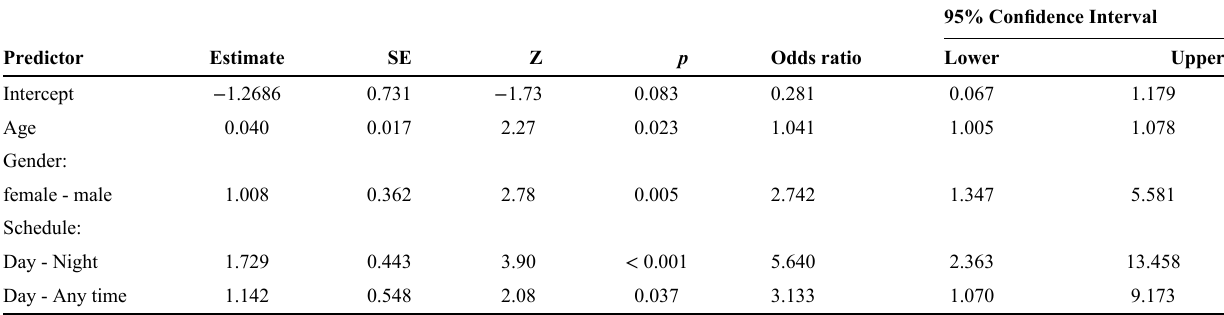
Table 4 - Model Coefficients (cid:0)